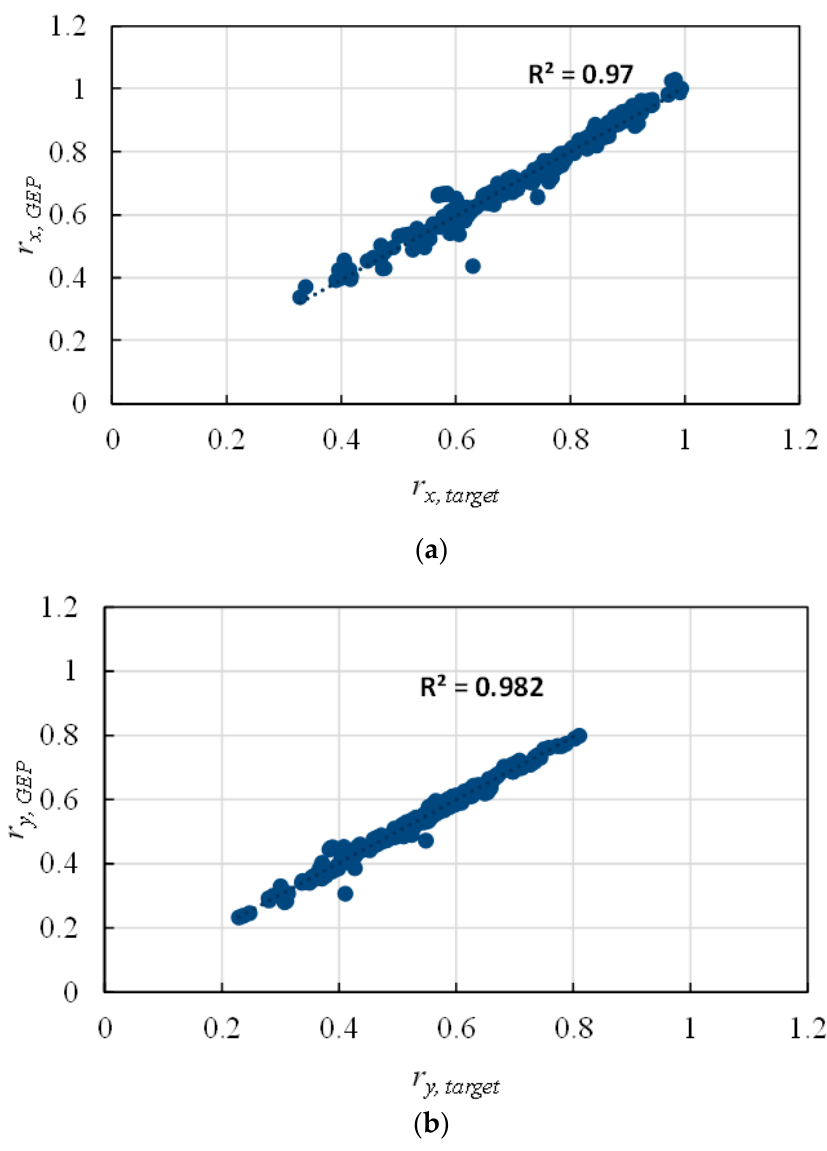
Figure 3. Predicted versus target effective stiffness ratio of reinforced concrete (RC) columns using the GEP model ( a ) r x , ( b ) r y . Table 2. Performance results of the GEP model.